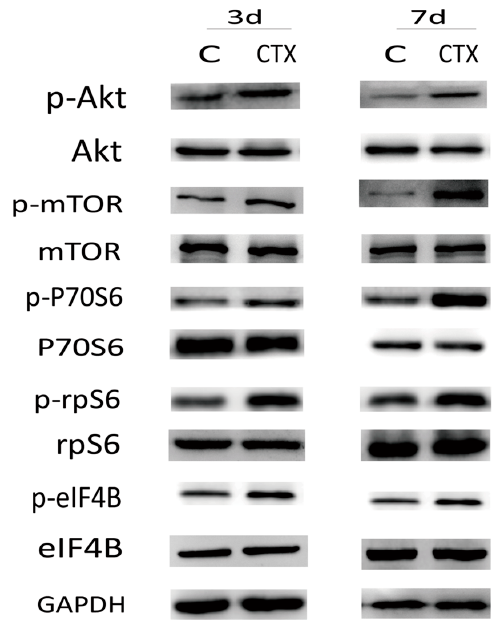
Figure 5. Cyclophosphamide induced increased phosphorylation of PI3K/Akt/mTOR signaling pathway proteins in the ovary: expression of Akt, mTOR, and the downstream P70S6-rpS6-eIF4B proteins. More than three ovarian samples of each group were analyzed by Western blot and we chose the representative images in the figure.